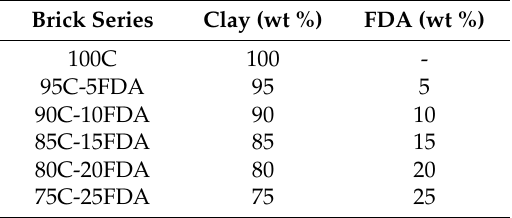
Table 1. Mixture proportions of raw materials for brick manufacturing.